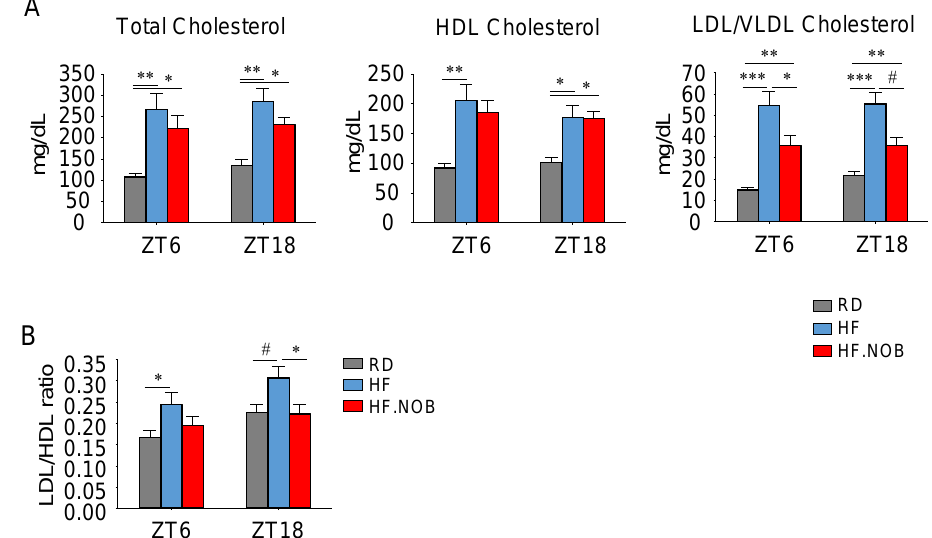
Figure 1. Nobiletin (NOB) improves cholesterol homeostasis in aged mice. ( A ) Serum total cholesterol levels, HDL cholesterol levels, LDL / VLDL cholesterol levels, and ( B ) LDL / HDL ratios were measured by colorimetric assays ( n = 6–8). RD: regular diet; HF: high-fat diet; HF.NOB: high-fat diet with 0.1% NOB. * p < 0.05, ** p < 0.01, *** p < 0.001, One-Way ANOVA; # p < 0.05, t-test. Bar graphs represent Mean ±